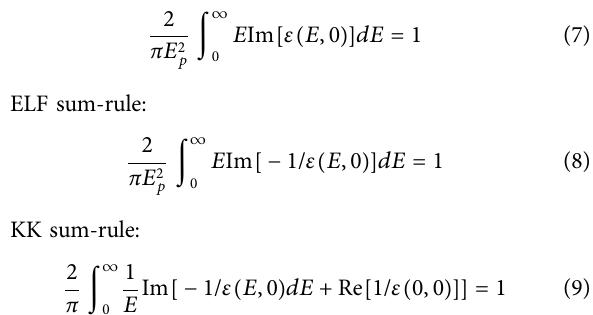
Frontiers in Physics |